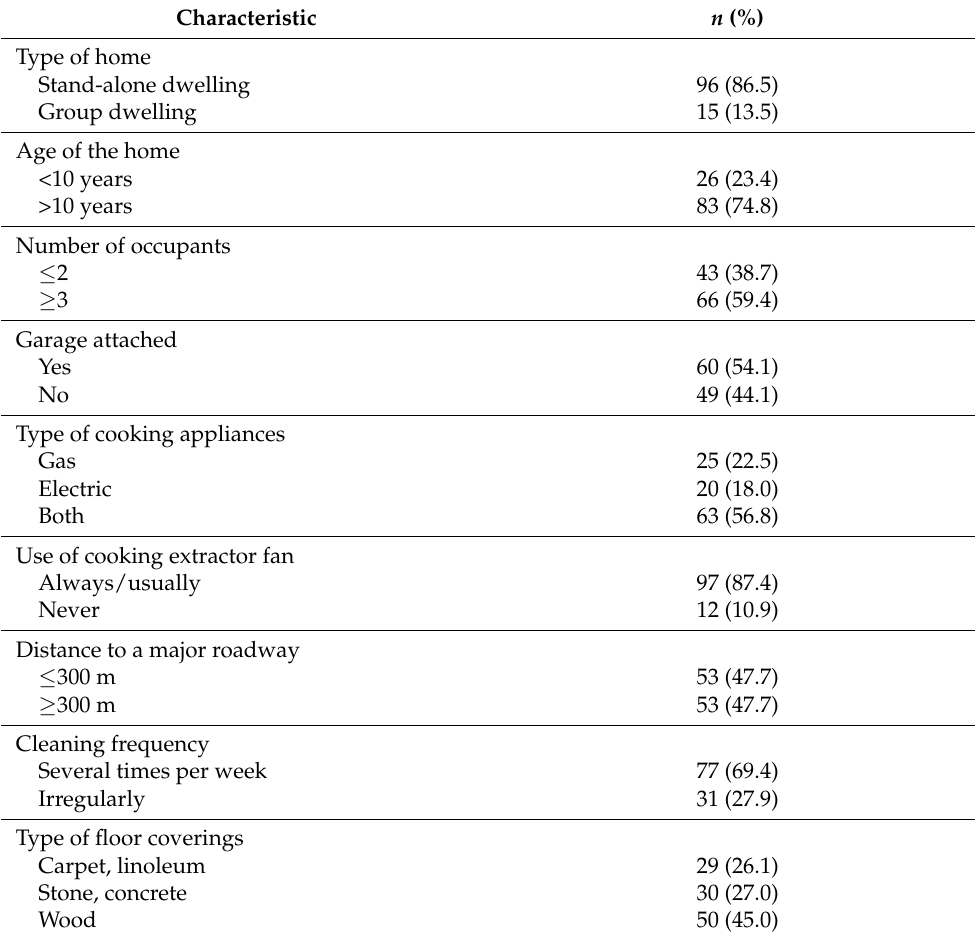
Table 4. Household characteristics of the study